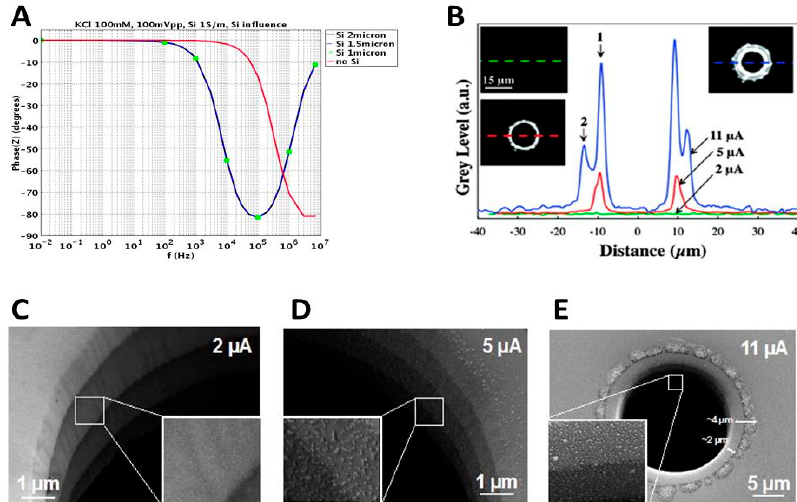
Figure 4. Evidences for the influence of the core silicon on CLEF deposition. ( A ) Computed impedance phases of the sandwich-like membranes without any core silicon layer (red line) or with various thicknesses of the core silicon layer (blue, green, and dashed lines are overlapped). ( B ) Fluorescence revelation of the deposition of PPy-ODNs in micropores. SEM pictures of gold nanobead deposits using current intensities of ( C ) 2 µA, ( D ) 5 µA, and ( E ) 11 µA.